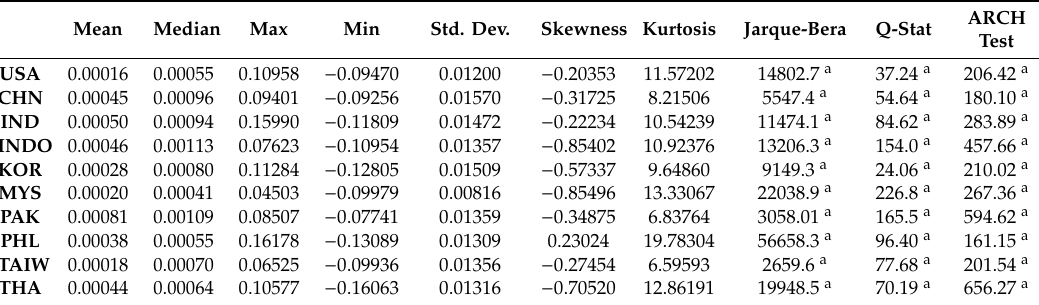
Table 1. Summary